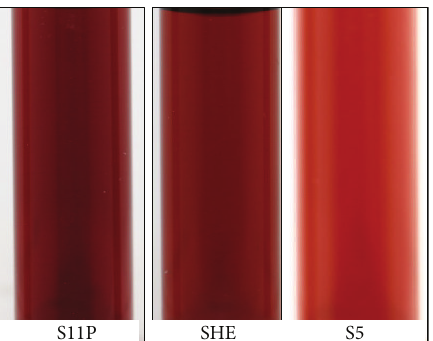
Figure 1: Supernatants of C. sedlakii (S11P), E. hermannii (SHE), and P. Putida (S5) after the addition of 1Mm of silver nitrate and incubation for 24 hr in light at room temperature.